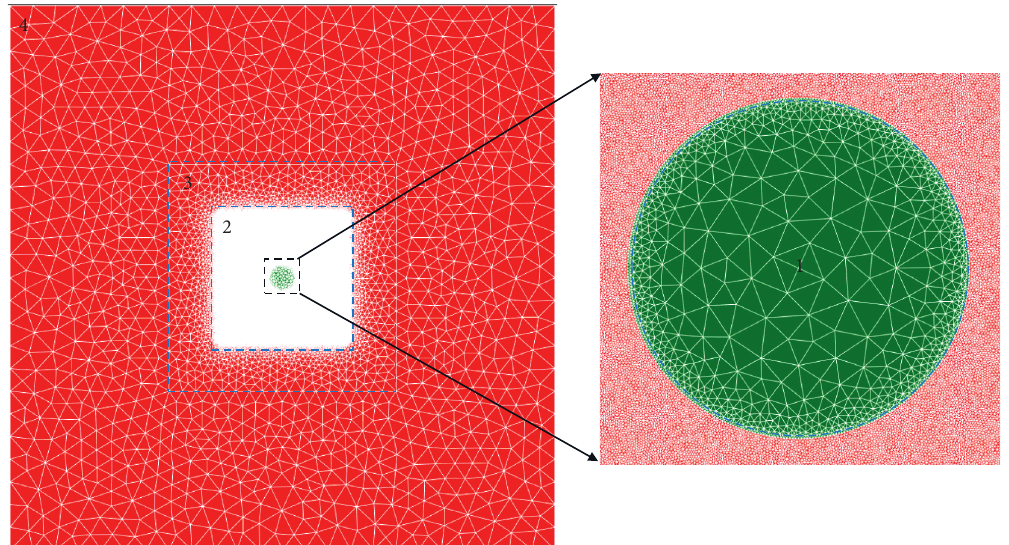
Figure 4: The geometric model of the URL test